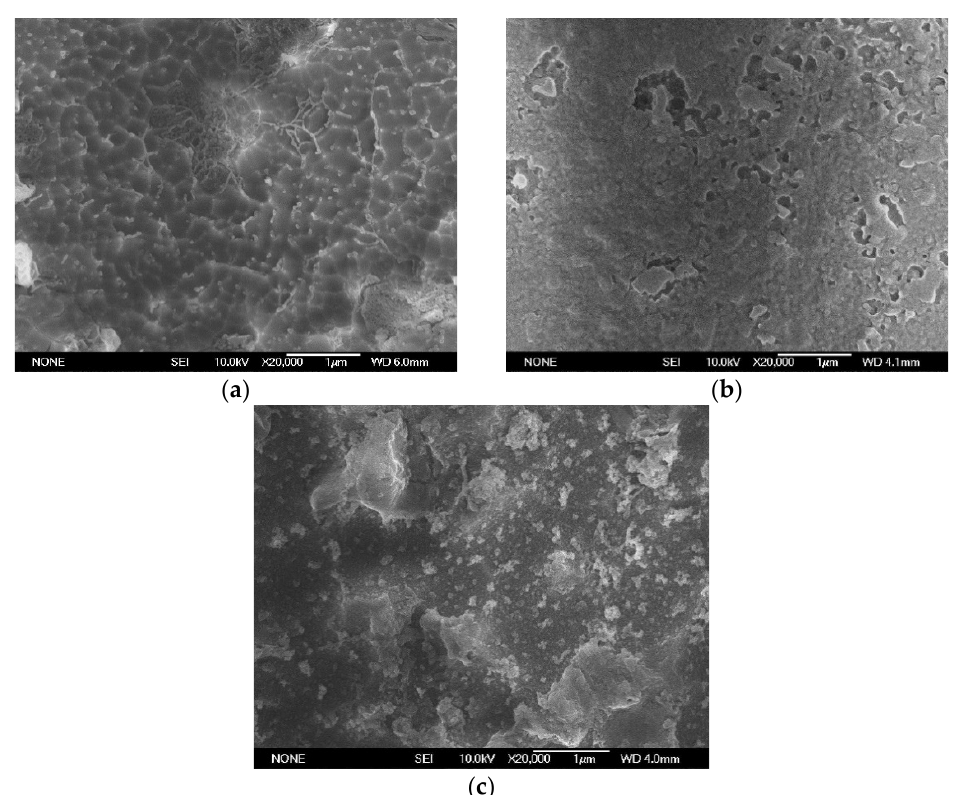
Figure 15. Surface morphology of materials after discharge. ( a ) G0-10 min, ( b ) G5-10 min, ( c ) G5-40 min.